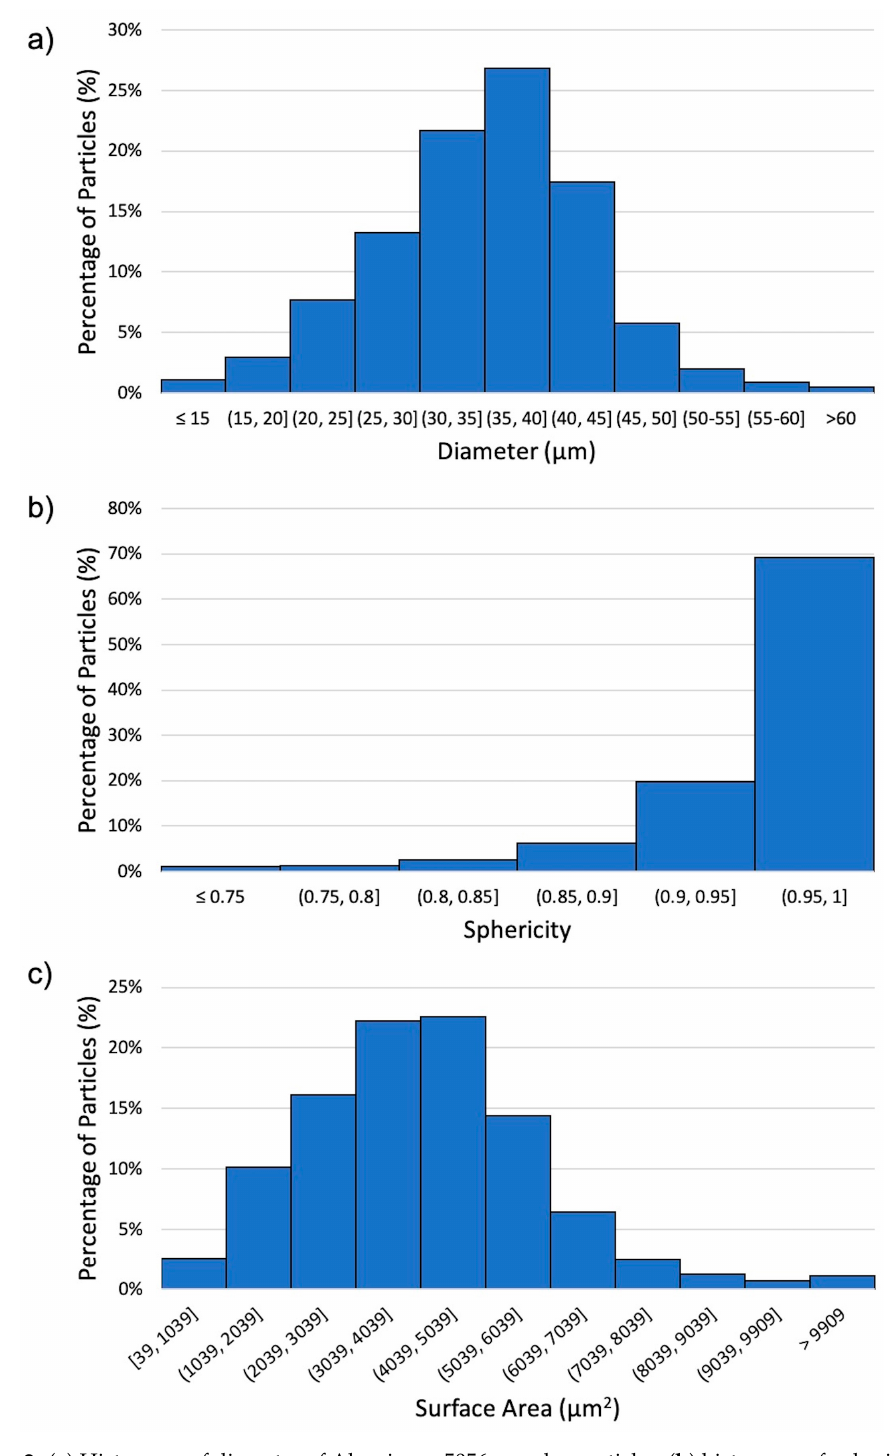
Figure 2. ( a ) Histogram of diameter of Aluminum 5056 powder particles; ( b ) histogram of sphericity of Aluminum 5056 powder particles; ( c ) histogram of surface area of Aluminum 5056 powder